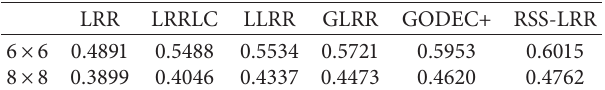
Figure 4: Clustering variation of different algorithms with varying noise levels on (a) ORL, (b) PIE, and (c) COIL20 datasets. original 6×6 occlusion 8×8 occlusion Figure 5: Example of the original image and corrupted one with different occlusion sizes on the COIL20 dataset. Table 5: Classification accuracies on ORL under 6 × 6 and 8 × 8 occlusions.